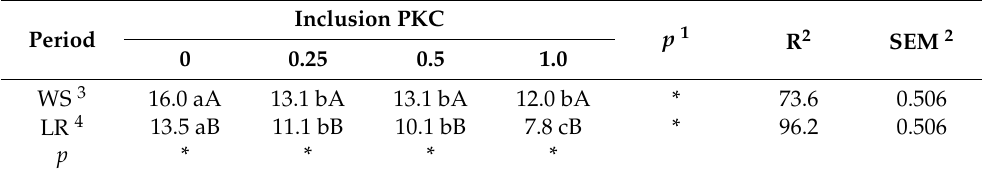
Table 5. Intake of non-fiber carbohydrates under the effect of interaction between treatment and period in buffaloes in the Amazon